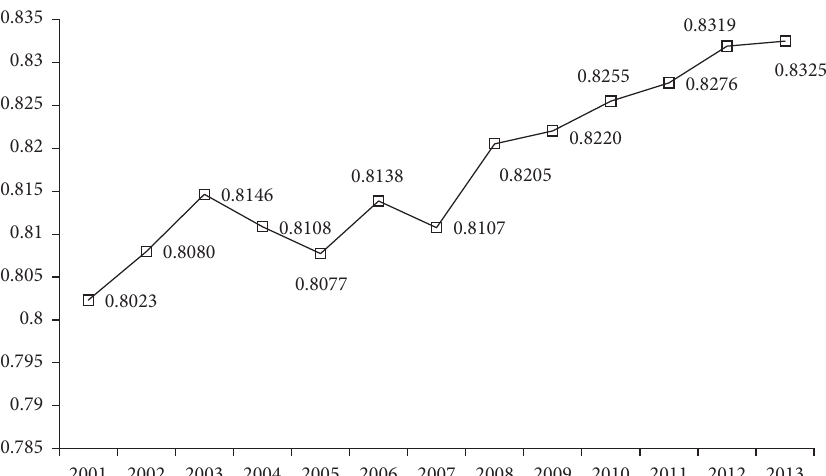
Figure 5: Evolution of clustering coefficient under undirected binary topology.